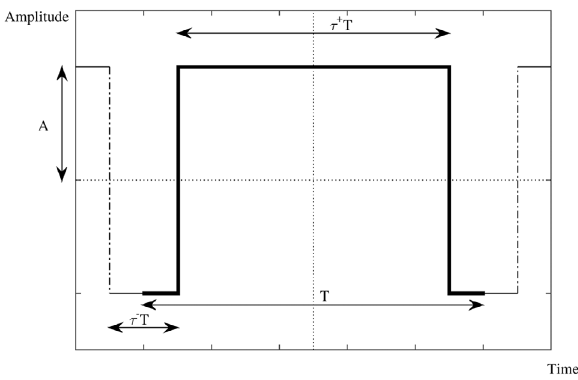
Figure 13. Asymmetric square